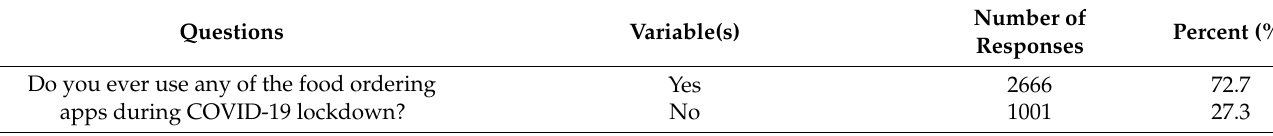
Table 2. Assessment of responses to the questionnaire questions among the participants (n = 3667) during COVID-19 lockdown